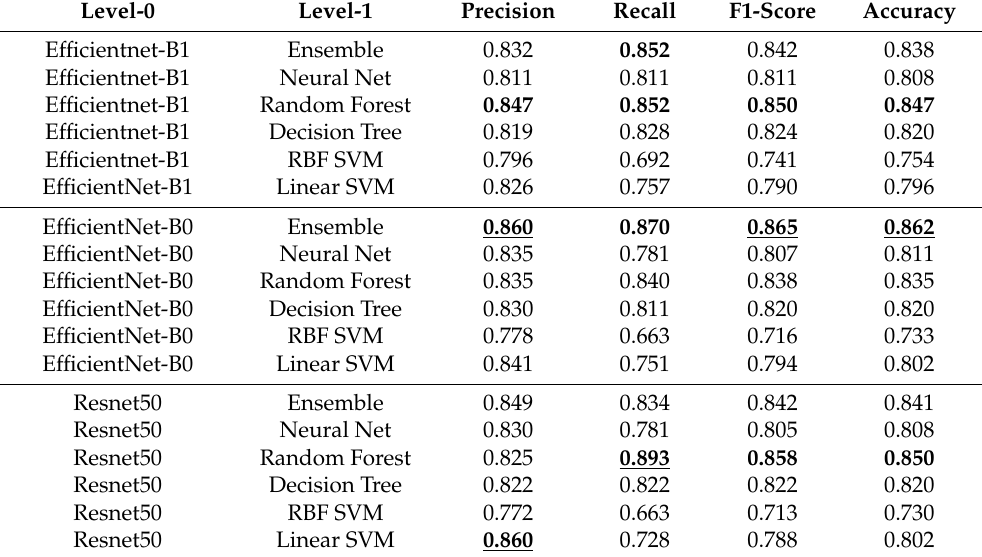
Table 3. The table presents the classification metrics for cascade generalization with DL models as level-0 models and conventional models as level-1 models. The metrics were calculated after applying a threshold of 0.5 to the probabilities.